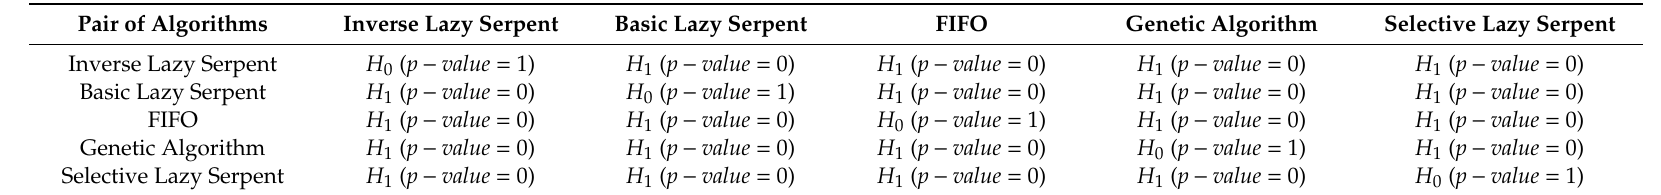
Table 4. Statistical comparison between the optimization algorithms based on the binomial sign test.